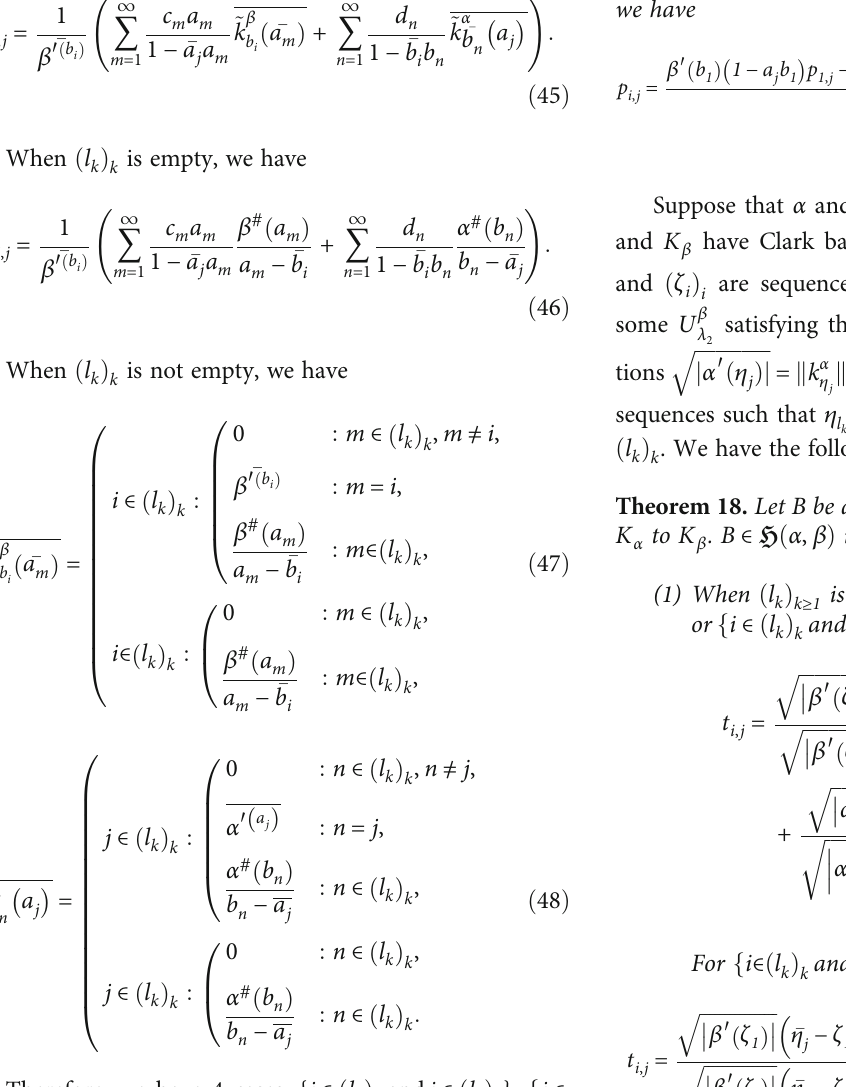
ffiffiffiffiffiffiffiffiffiffiffiffiffiffiffiffi (cid:12) β ′ ζ ð Þ (cid:12) 1 ffiffiffiffiffiffiffiffiffiffiffiffiffiffiffi (cid:12) β ′ ζ ð Þ (cid:12) i